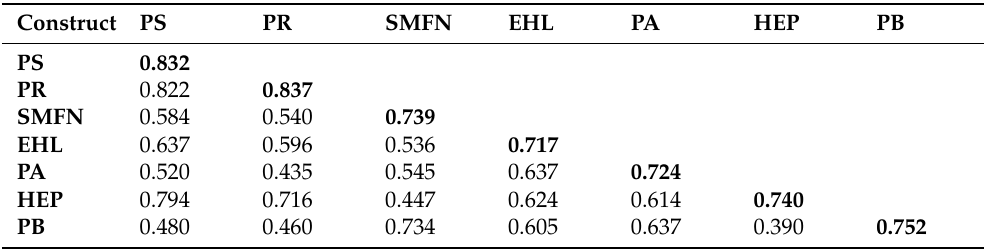
Table 5. Fornell-Larcker Criterion.